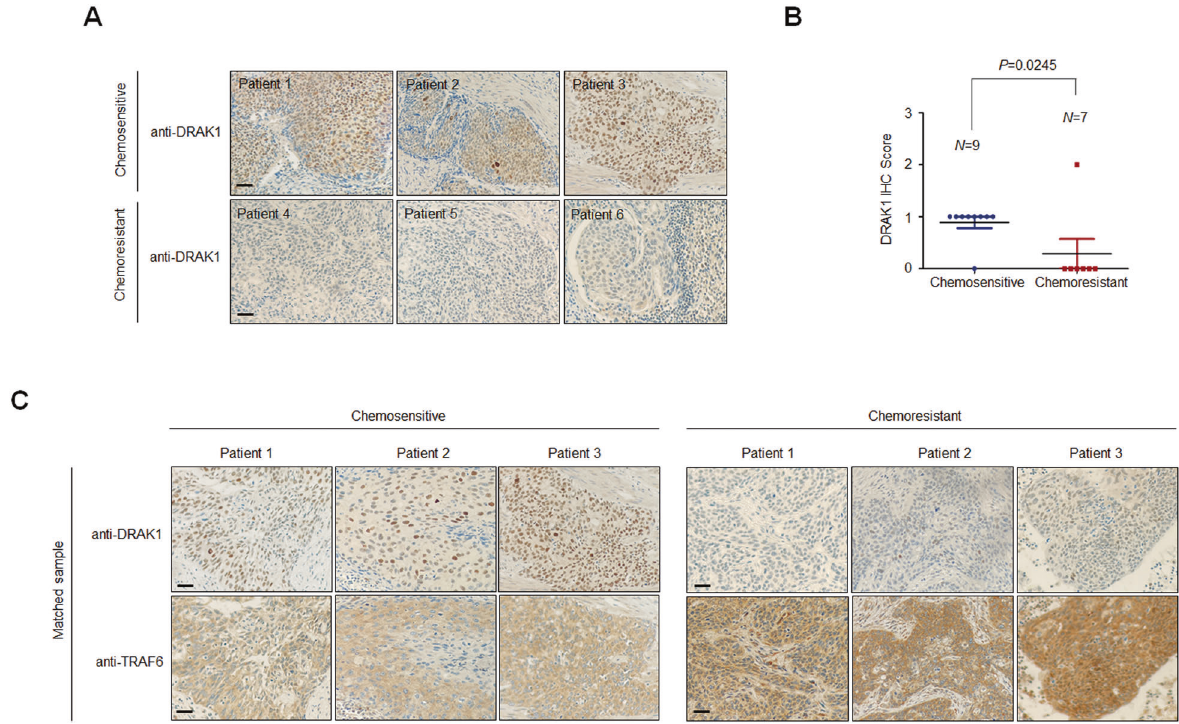
Fig. 2 DRAK1 is signi fi cantly underexpressed in chemoresistant cervical cancers. A Representative IHC image showing the expression of DRAK1 in chemosensitive or chemoresistant cervical cancer patient TMAs. Original magni fi cation 200x. Scale bar, 50 μ m. B Scatter plots showing the IHC score of DRAK1 from A. P values were calculated by paired two-tailed Student ’ s t tests. C Representative IHC image showing the expression of DRAK1 and TRAF6 in matched samples from TMAs. Original magni fi cation 200x. Scale bar, 50 μ